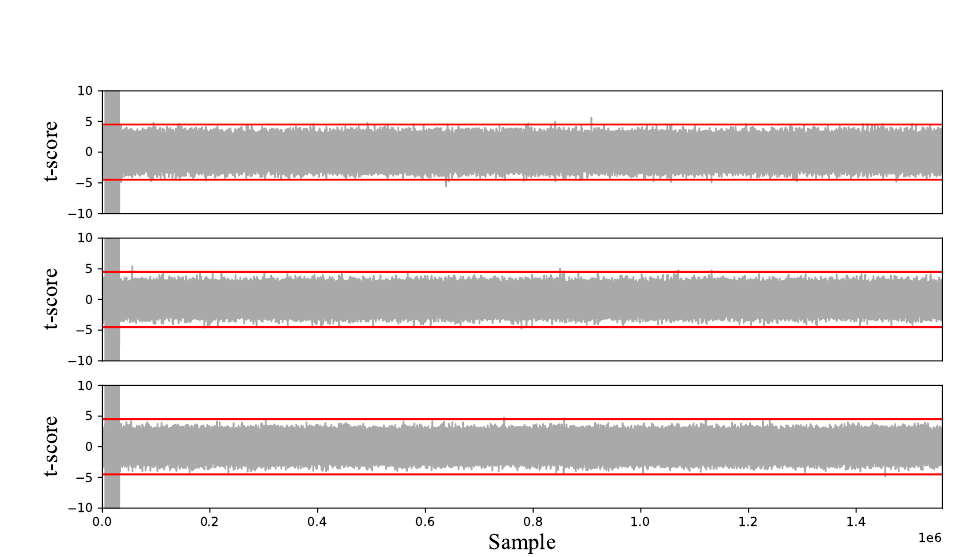
Figure 11: TVLA (t-test) results for IPM2 (top), IPM3 (middle) and IPM14 (bottom) with TRNG activated and sampling rate at 156 MHz. The red lines mark the ± 4 . 5 threshold.